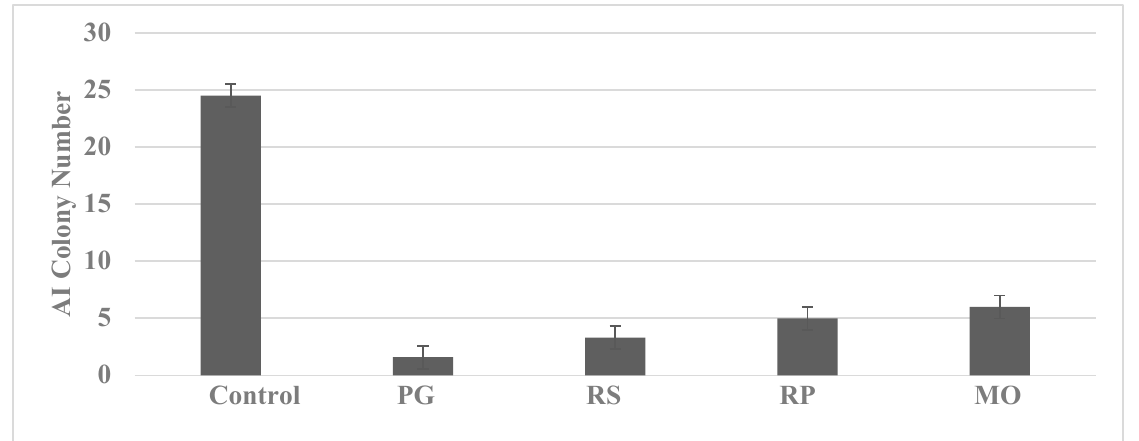
Figure 5. Inhibition of AI colony formation by nutritional herbs. PG, Pseudo ginseng ; RS, Radix salviae ; RP, Radix paeoniae ; MO, Morinda officinalis .